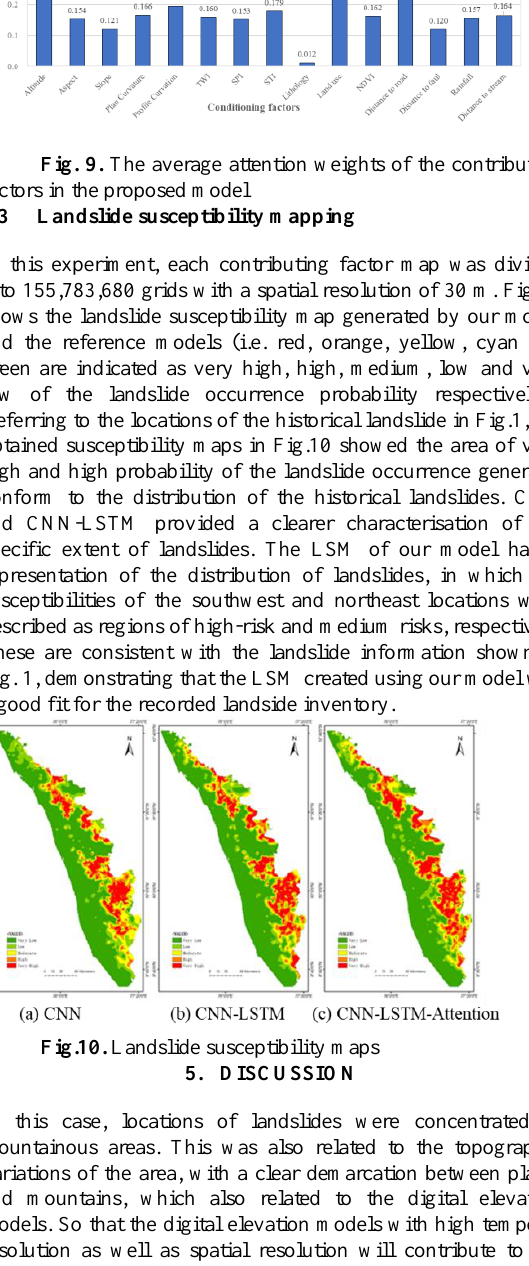
Fig. 6. Learning curve of Loss value and accuracy using CNN with LSTM